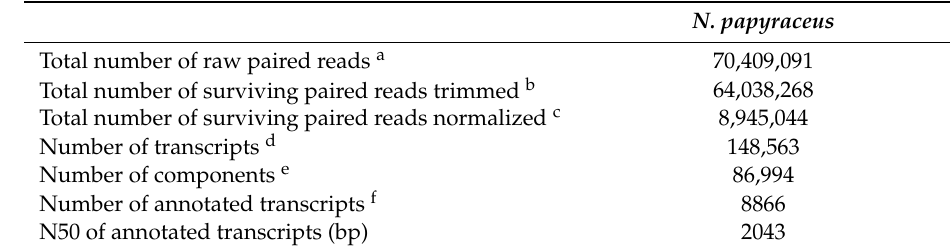
Table 1. Summary of the transcriptome database generated from one lane of Illumina RNA-Seq of Narcissus papyraceus stage 1